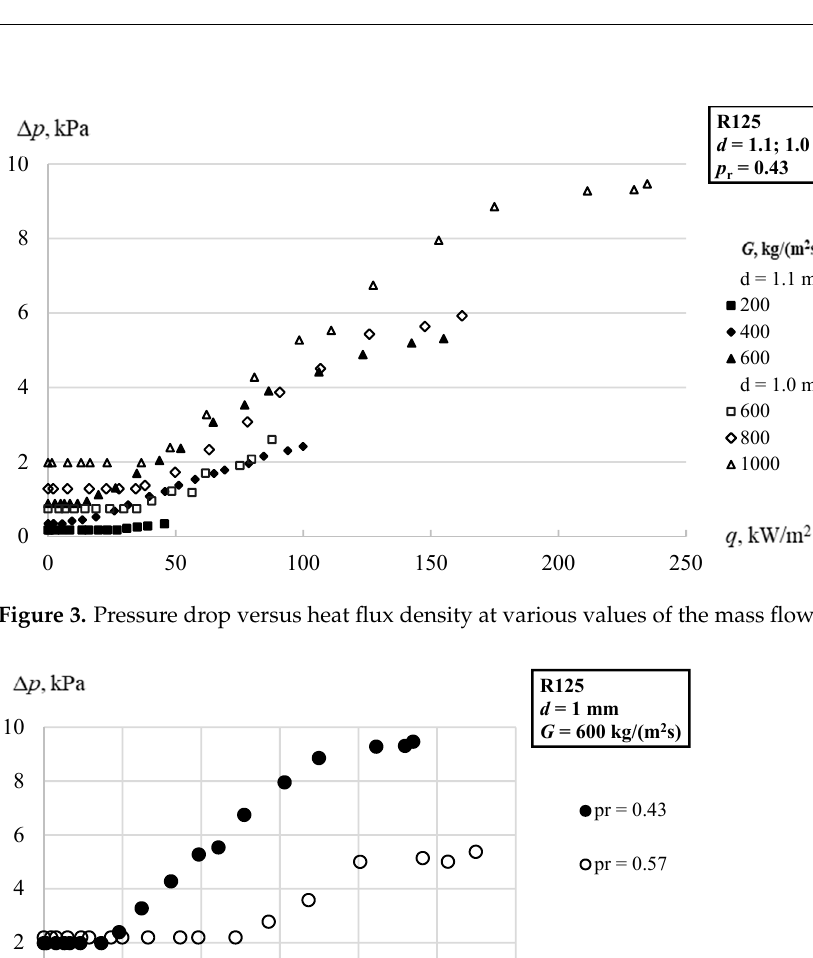
Figure 5. Example of the experimental data with calculated data versus heat flux.